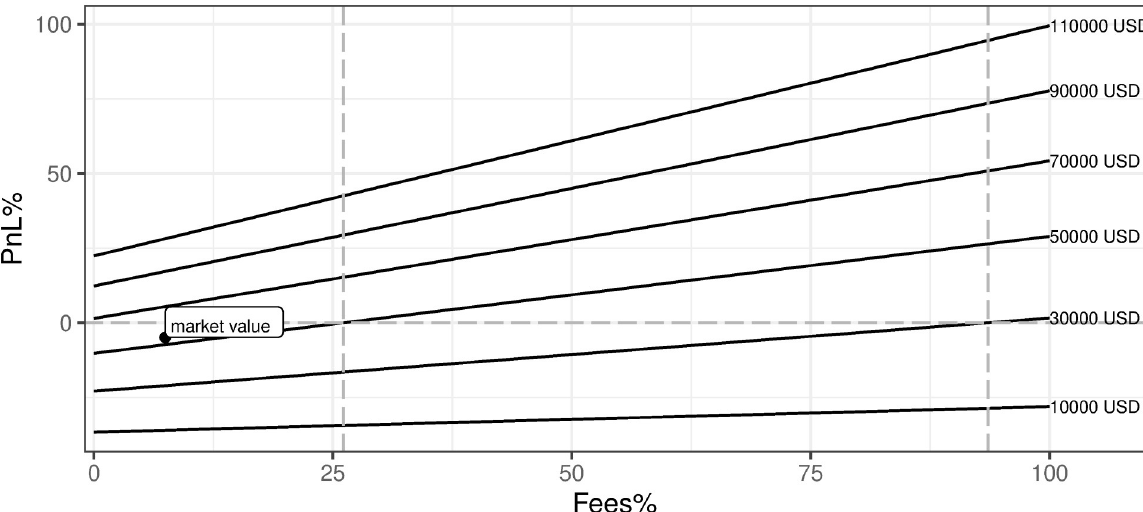
Fig 29. BTC mining profitability (PnL%) for different levels of fees defined as % of BTC mined and different levels of BTCUSD price. Note: PnL%, calculated according to the formula 6. Hypothetical transaction fees range from 0% up to 100% of BTC mined and BTCUSD price ranges from 10000 USD up to 110000 USD. The market value point describes the current state of market mining efficiency assuming parameters outlined in the section Values of variables as of 2021/12/03. Source: own calculations based on data described in section Crucial assumptions and data.